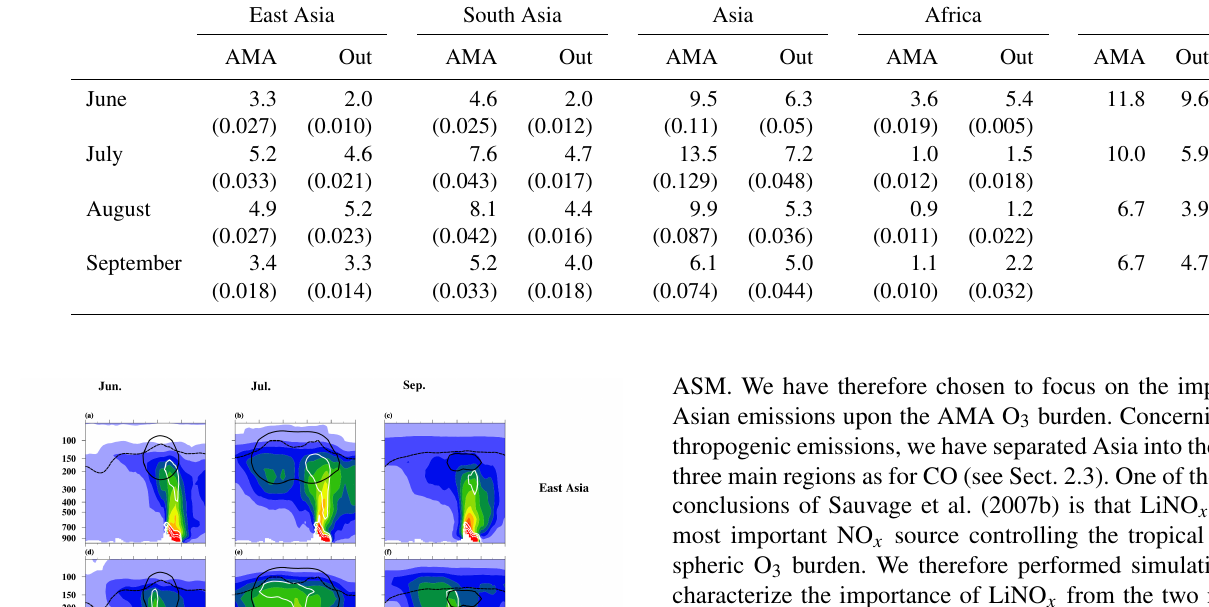
Table 3. Monthly O 3 and NO x from different sources inside and outside of the AMA in ppbv. The values for NO x are given in brackets. Anthropic Anthropic